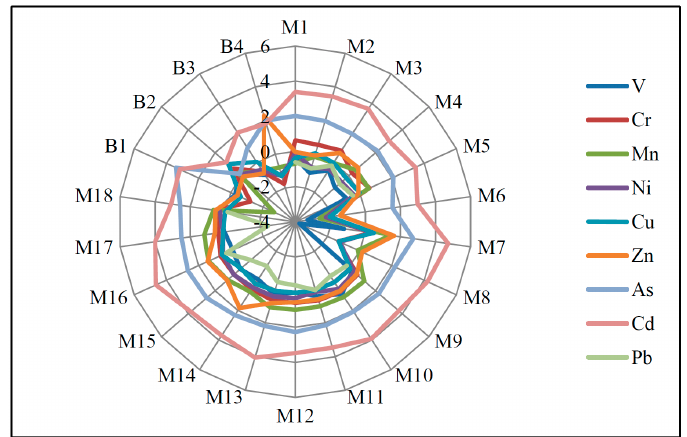
Figure 4. Geo-accumulation index (I geo ) of heavy metal(loid)s of the SPM.